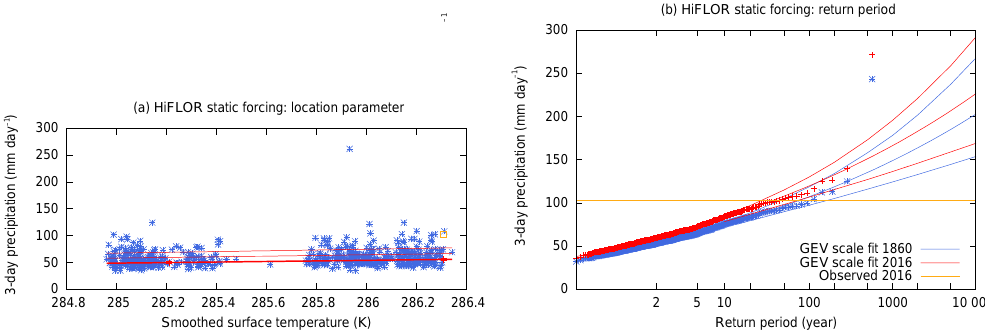
Figure 13. The same as Fig. 4 but for the annual and spatial maximum 3-day average precipitation in the HiFLOR static forcing experiments.